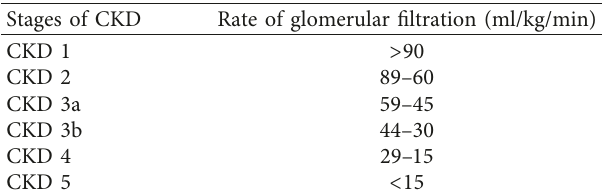
Table 1: CKD and glomerular filtration rate. Stages of